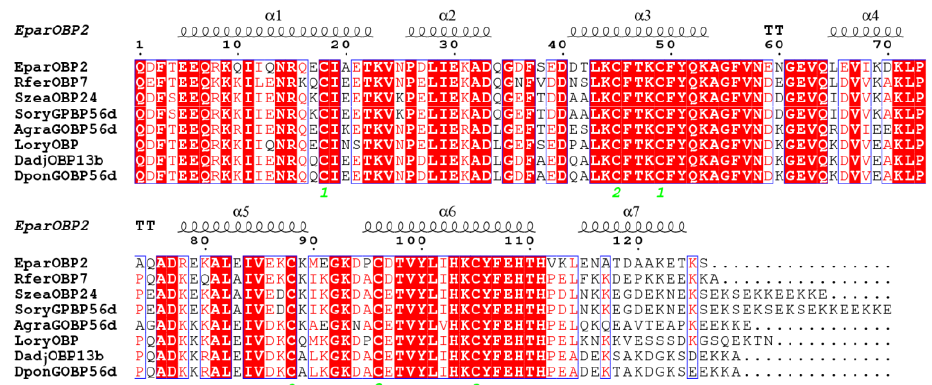
Figure 2. Alignment of EparOBP2 with OBP genes from other Curculionidae insects. Anthonomus grandis (Agra), Dendroctonus ponderosae (Dpon), Dendroctonus adjunct (Dadj), Lissorhoptrus oryzophilus (Lory), Rhynchophorus ferrugineus (Rfer), Sitophilus oryzae (Sory), Sitophilus zeamais (Szea). A phylogenetic tree was constructed using the EparOBP2 and 19 OBP sequences of other Coleoptera species to evaluate the evolutionary relationships between proteins.